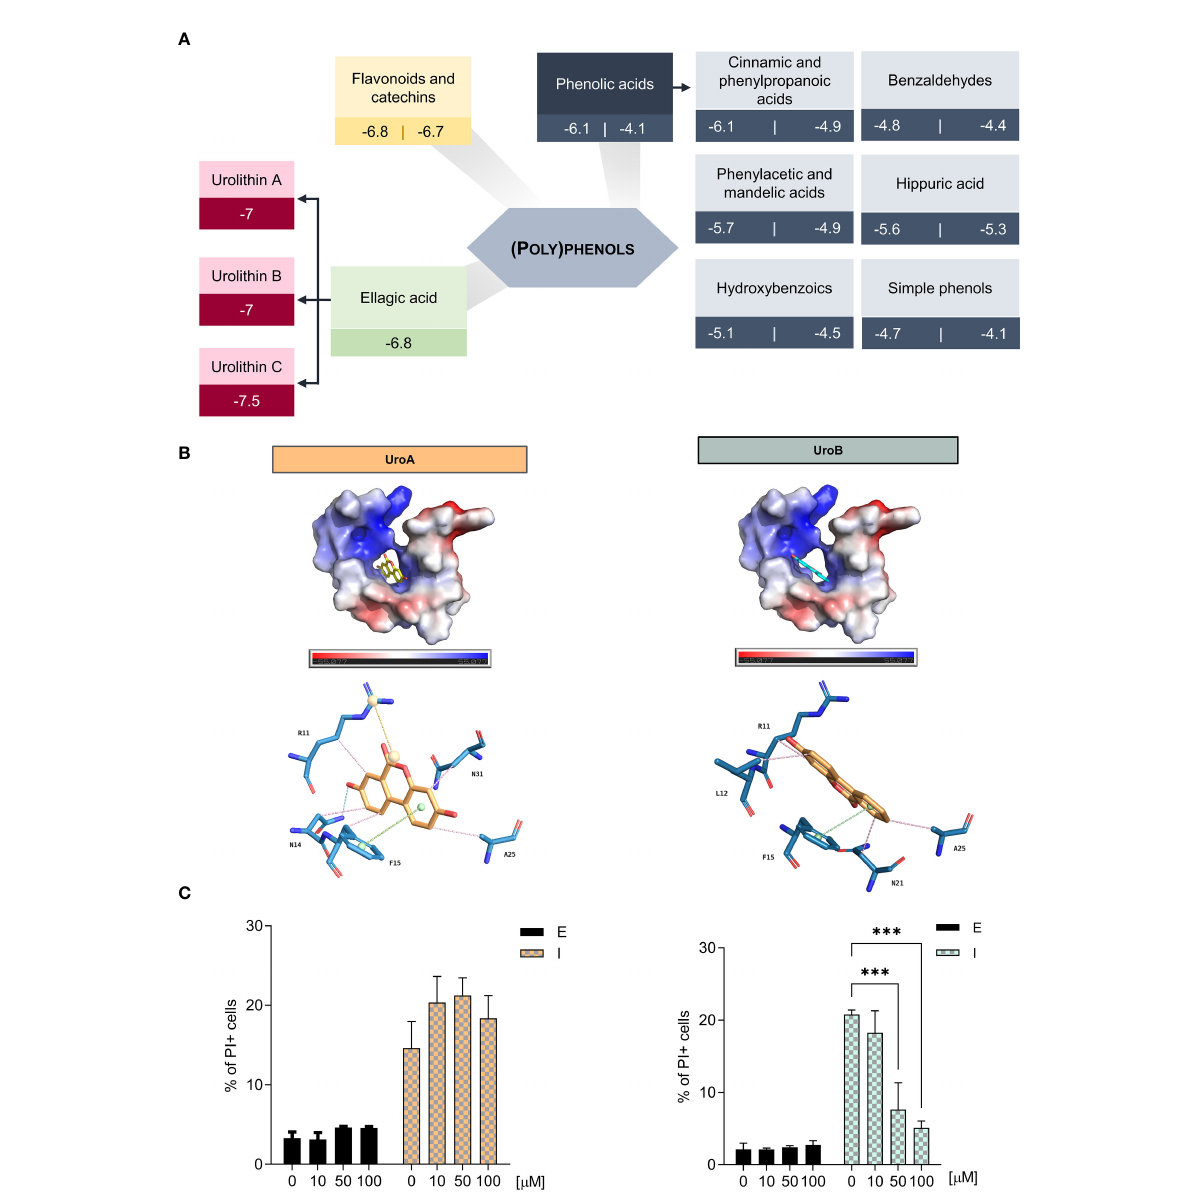
FIGURE 1 Urolithin B is the (poly)phenol metabolite with better potential for hampering IAPP aggregation (A) Docking simulations of IAPP and (poly)phenols by AutoDock Vina reveals urolithins as the best performing molecules. (B) Vacuum electrostatics of urolithin A (UroA) and urolithin B (UroB) docking in IAPP using Pymol (upper panel). Predicted bond analysis of UroA and UroB with IAPP amino acid residues (lower panel). Green – p - stacking. Pink – Hydrophobic interactions. Blue – hydrogen bonds. Yellow – Salt bridges. (C) The frequency of propidium iodide (PI) positive cells was assessed by fl ow cytometry in cells expressing ppIAPP and the respective control in the presence of UroA (left) and UroB (right). The values represent mean ± SD from at least three independent experiments. Statistical differences are denoted as *** p < 0.001 vs. the control condition. E – cells containing the empty vector. I – cells expressing